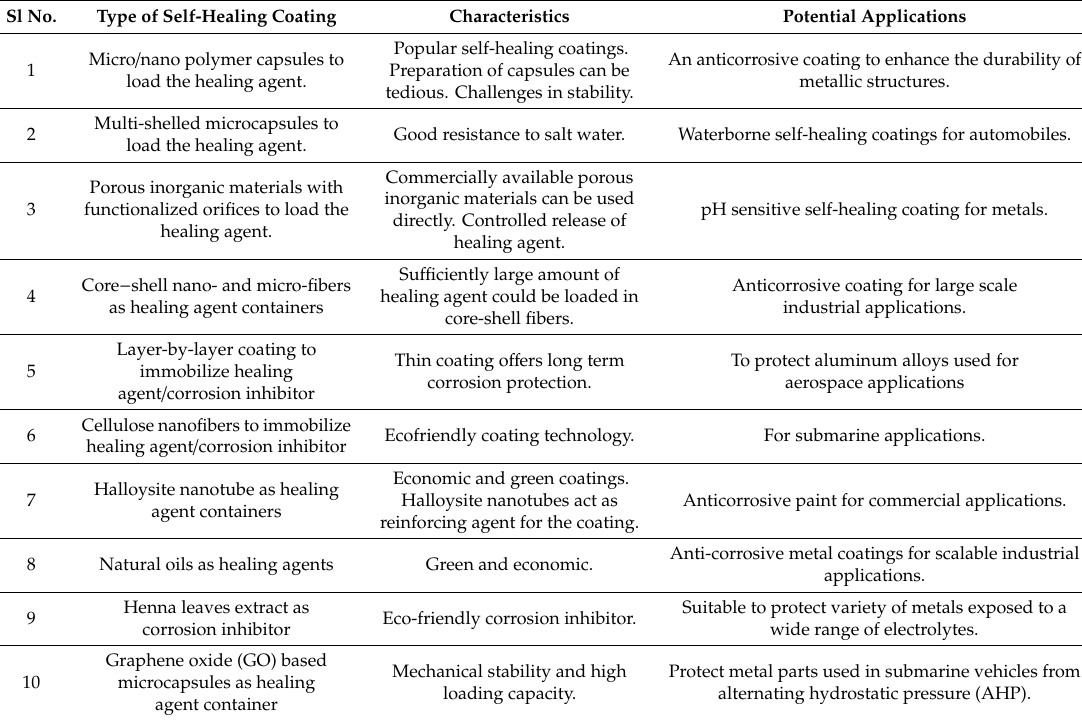
Table 1. Di ff erent type of self-healing coating, key characteristics, and potential application. Sl